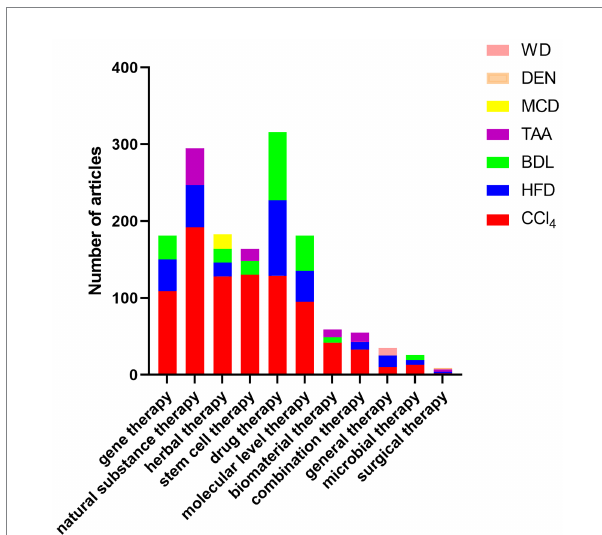
treatment: Among the collected articles, the details of the top three animal models used in articles in each field of treatment are as follows: gene therapy: CCl 4 (109), HFD (41), BDL (31); natural substance therapy: CCl 4 (192), HFD (55), TAA (48); herbal therapy. CCl 4 (128), MCD (19), BDL (18), HFD (18); stem cell therapy: CCl 4 (130), BDL (18), TAA (16); drug therapy: CCl 4 (129), HFD (98), BDL (89); biomaterial therapy: CCl 4 (42), TAA (10), BDL (7); microbiological treatment: CCl 4 (13), BDL (7), HFD (6); surgical treatment: TAA (3), DEN (2), CCl 4 (2), HFD (2); general treatment: HFD (15), WD (10), CCl 4 (10); molecular level treatment: CCl 4 (95), BDL (46), HFD (40); combination therapy: CCl 4 (33), TAA (12), HFD